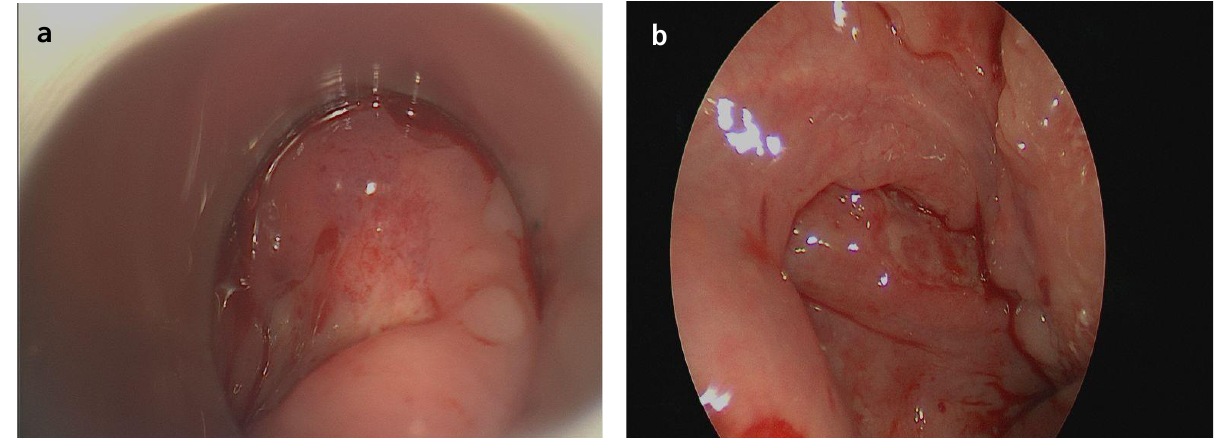
Figure 1. Oro- and hypopharyngeal EBV-MCU presenting as a well-circumscribed ulcer on the right